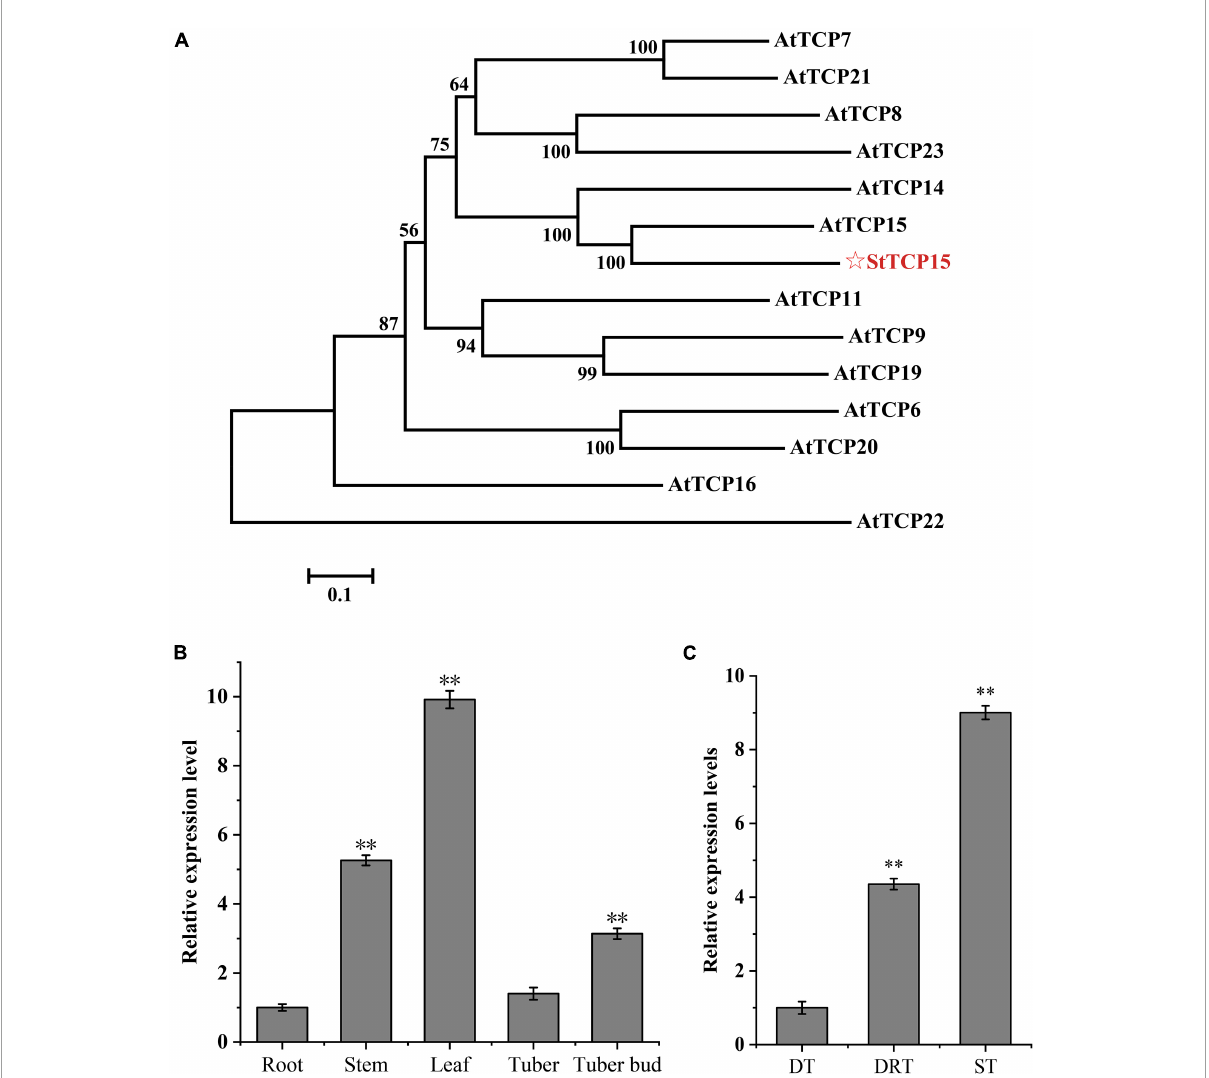
FIGURE1 Analysis of potato StTCP15. (A) The phylogenetic tree of PCF class and StTCP15 in Arabidopsis thaliana . (B) The relative expression level of StTCP15 in different organs of potato. (C) The relative expression levels of StTCP15 genes during release of tuber dormancy. DT: Dormant tuber (0 day); DRT: Dormant release tuber (30 day); ST: Sprouting tuber (45 day). Relative expression levels, determined by qRT-PCR, relative to the expression of the StEF1 α gene, expressed as 2 − (cid:49)(cid:49) Ct . Each column represents the mean values ± SE ( n = 3; ∗∗ P <